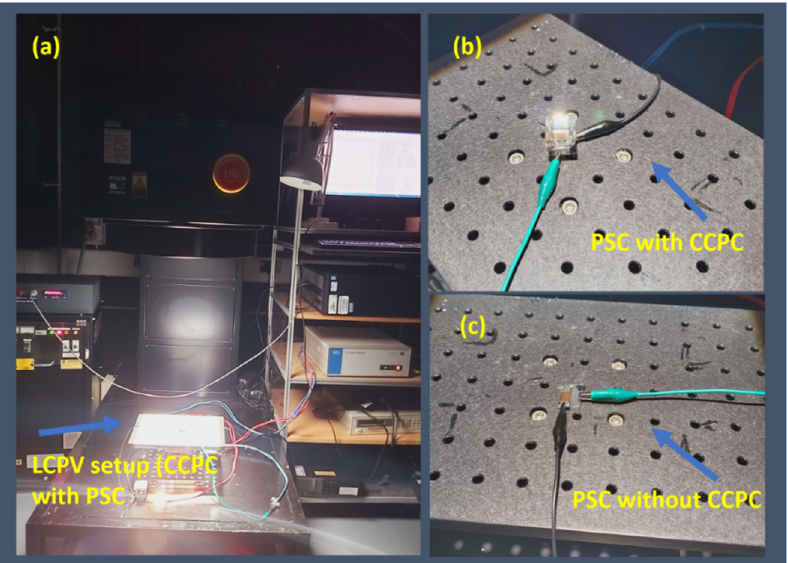
Figure 3. ( a ) Photograph of the experimental characterization of the CCPC-integrated-PSC ex- posed under different sun conditions, starting with 1000 W/ m 2 , followed by 800 W/m 2 , 600 W/m 2 , and 400 W/m 2 at 1.5 AM with room temperature at 22 °C; the active area of the device was 1 cm 2 , ( b ) PSC with CCPC and ( c ) PSC without